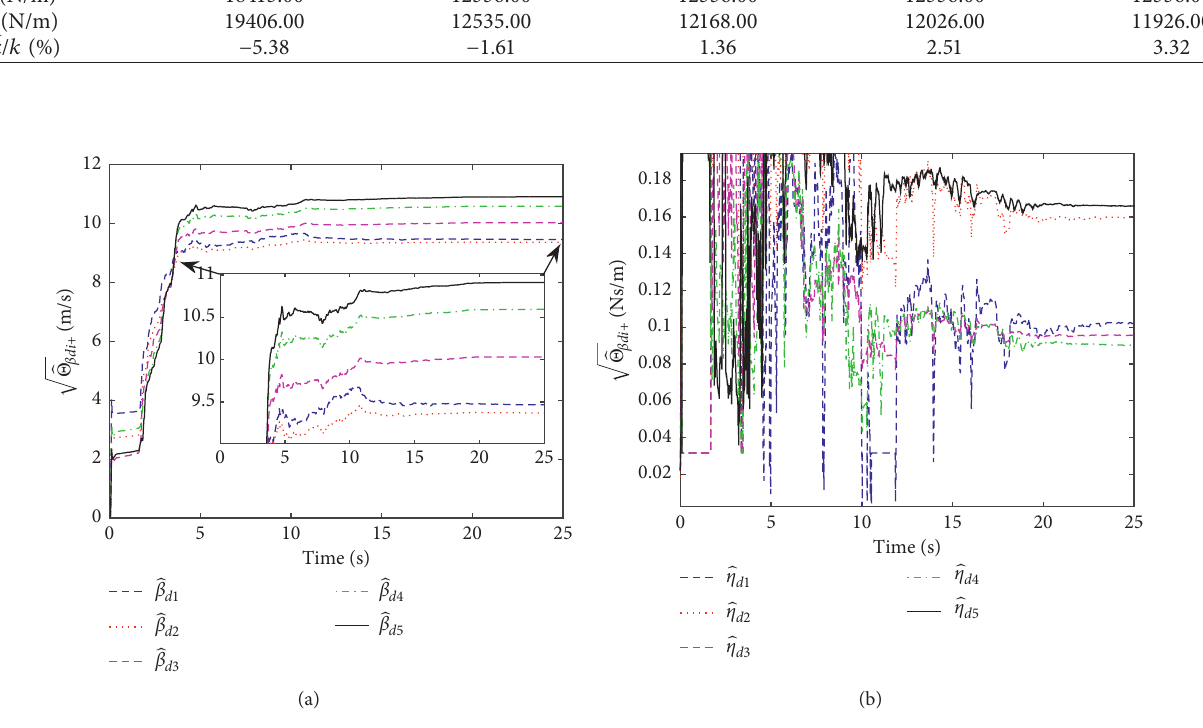
Figure 7: Identified parameters from thedamagebuilding atthesecond story.(a)Evolutionof